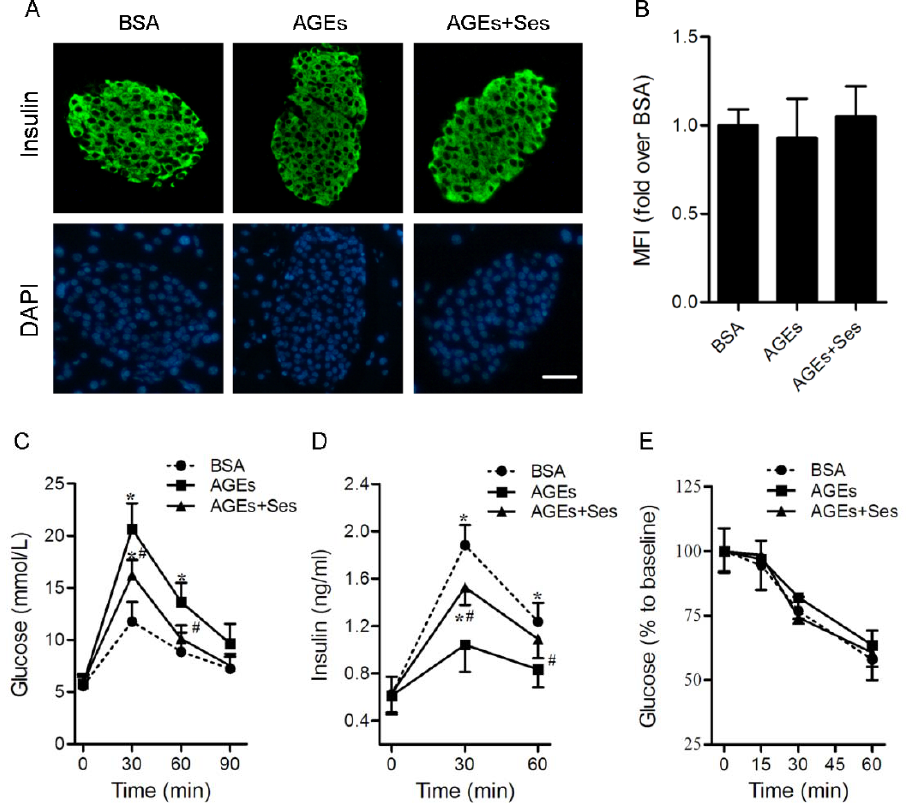
Figure 2. Effects of sesamin on insulin content, GTT, IRT and ITT in mice. C57BL/6J mice were injected intraperitoneally with BSA (120 mg/kg, as a control), AGEs (120 mg/kg) or AGEs plus sesamin (160 mg/kg) for 4 weeks. ( A ) Representative photomicrographs of immunofluorescent staining for insulin in pancreatic islets. Scale bar = 50 μ